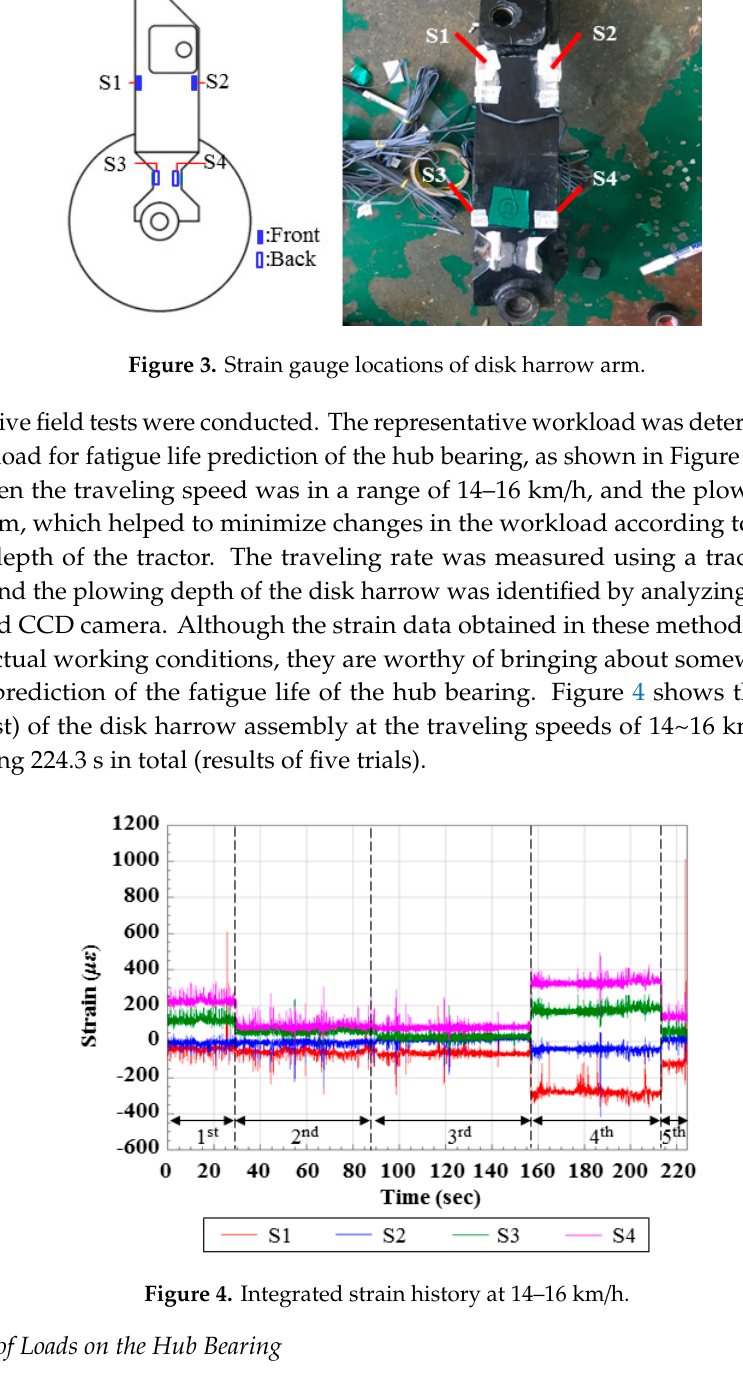
Figure 4. Integrated strain history at 14–16 km/h.